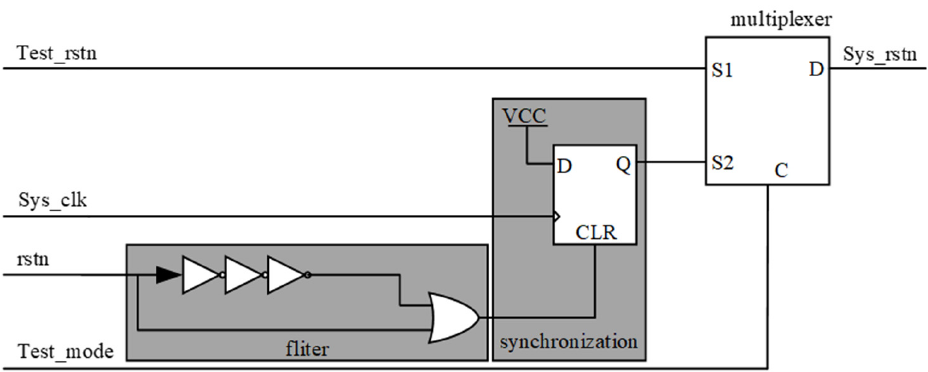
Figure 5. The reset structure.